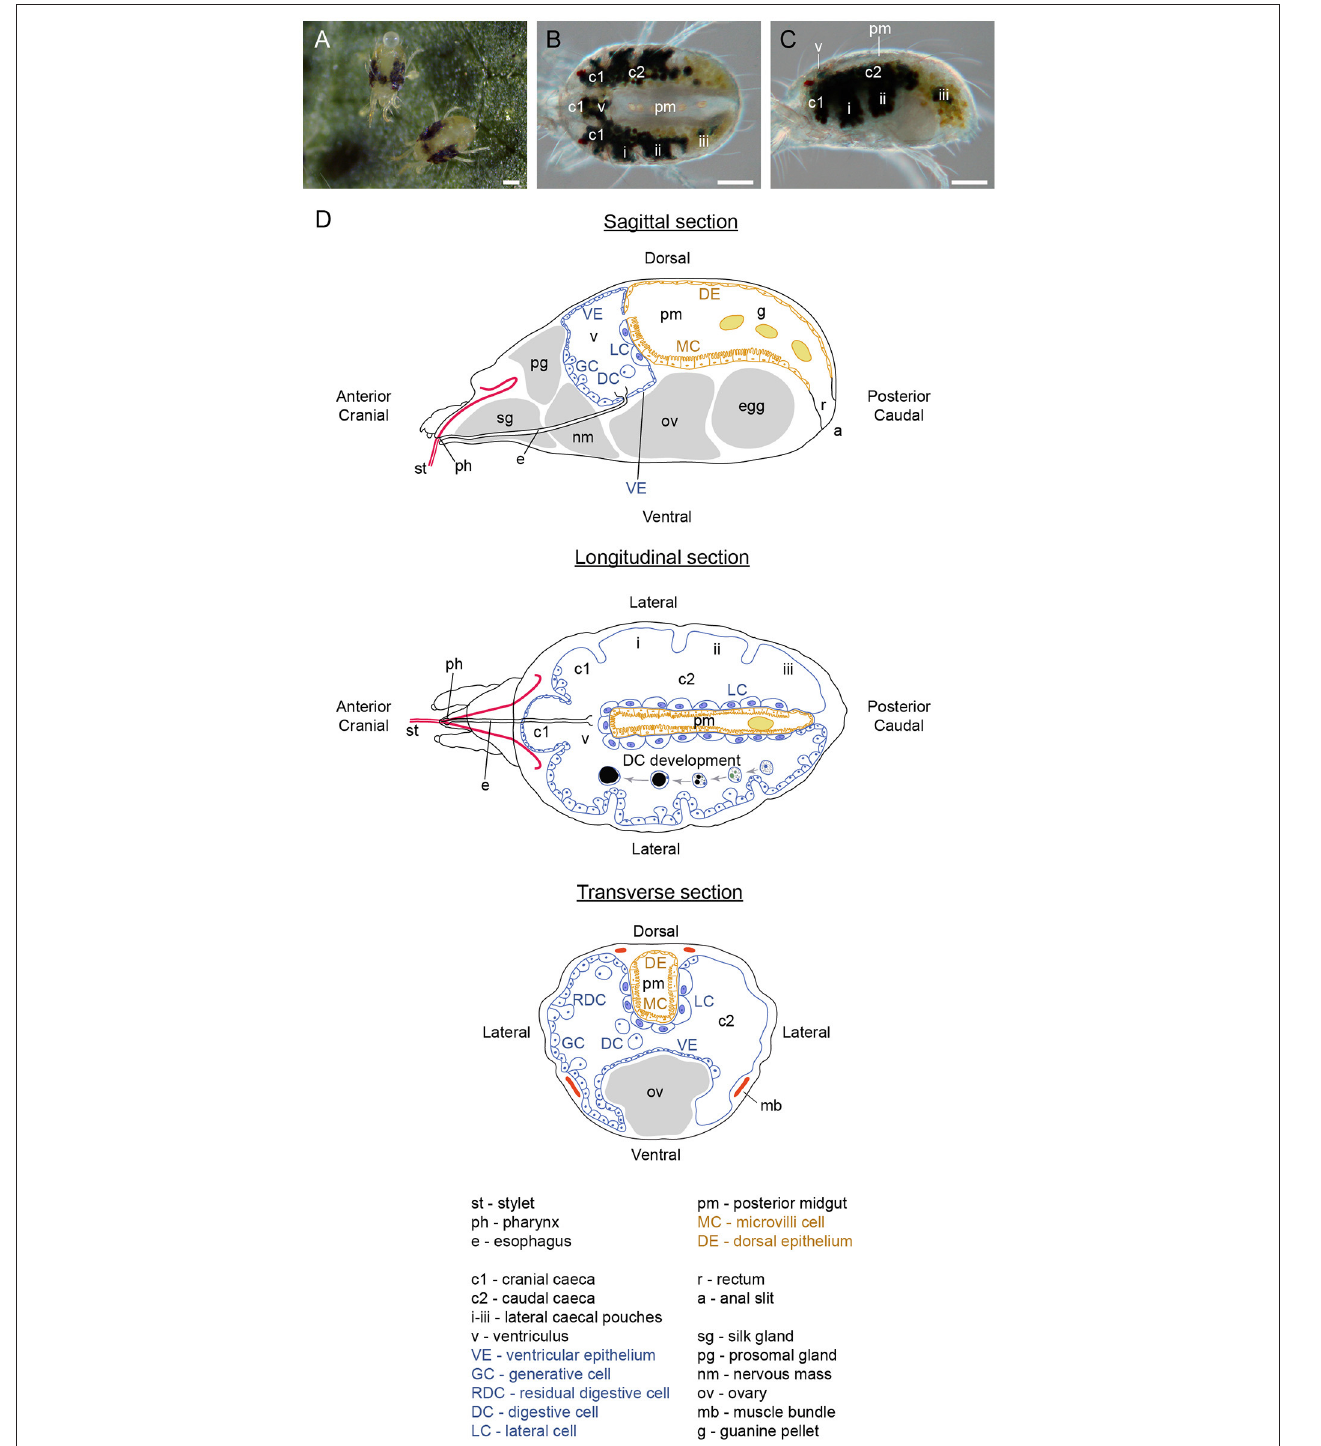
FIGURE 1 | Organization of spider mite body. (A) Spider mite females on bean ( Phaseolus vulgaris ) leaf. (B) Dorsal view of female spider mite. (C) Lateral view of female spider mite. (D) Schematics of spider mite internal anatomy. Scale bars (A–C) : 100 µ m.